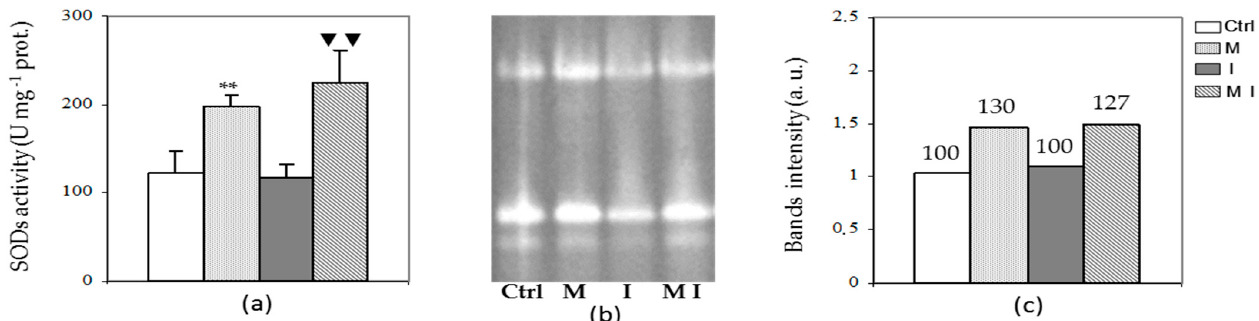
Figure 6. Spectrophotometric analysis ( a ), electrophoretic pattern of Native-PAGE ( b ), and related densitometric analysis ( c ) in the cytosolic fraction of superoxide dismutase (SOD) of artichoke control plants (Ctrl), mycorrhizal plants (M), plants inoculated with Verticillium dahliae (I), and in mycorrhizal plants inoculated with V. dahliae (MI); 1 U= the amount of enzyme required to inhibit the reduction rate of NBT by 50% at 25 °C; prot. = proteins; a.u. = arbitrary units. The results are given as the mean values of at least five experiments ± SD; * * and ▼▼ indicate values significantly different from the control (Ctrl) and from the artichoke inoculated with V. dahliae , respectively, by the Student’s t test with p < 0.01.